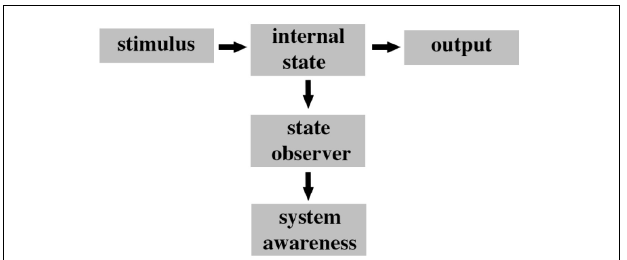
FIGURE 3 | Fundamental organization of a system with awareness potency. The ground state of the system represents a stimulus response module whereby a stimulus (i.e., input) produces a change in the internal state of the system and this in turn leads to a specific output. In order for the system to begin to be aware of what it is doing there must be some independent process of observing changes in its own internal state. This process is performed by a state observer module that detects changes in the internal state that are responsible for the output. The state observer has a low level of awareness (e.g., a temperature gauge in a car engine is a state observer). An additional system awareness module needs to subsequently monitor changes in the state observer and to interpret this information in context of the overall functioning of the system. This second layer of monitoring represents a higher level of awareness (i.e., awareness of awareness). For instance, in the example of an engine temperature this module would detect rises in temperature and determine their significance to the car in respect to overall performance of the